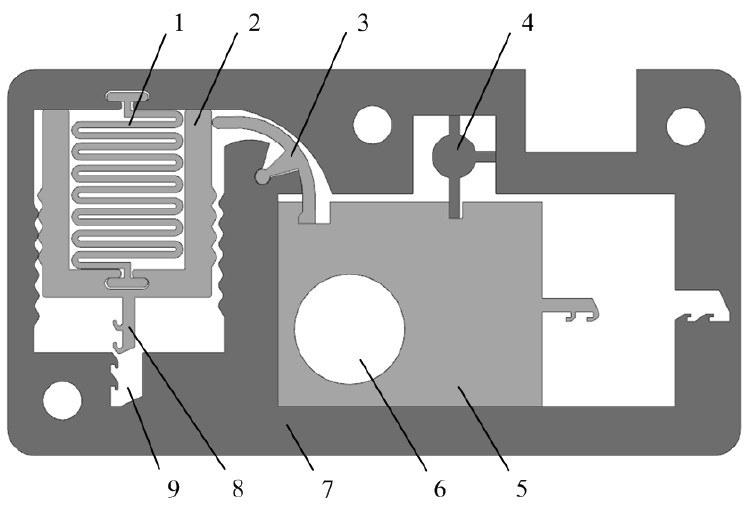
Figure 4. MEMS S & A device. (1) Microspring, (2) Setback slider, (3) Rotary pin, (4) Shear pin, (5) Arming slider, (6) Fire hole, (7) Frame, (8) Head latch, (9) Cassette latch.